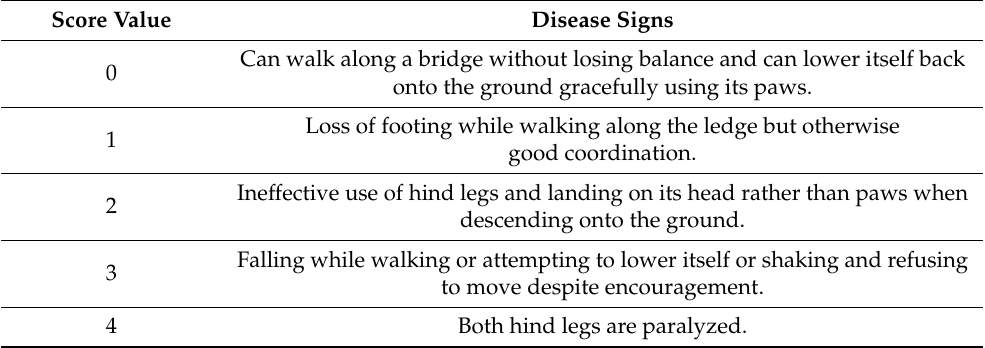
Table 2. Experimental neuromyelitis optica-score. Score Value Disease Signs